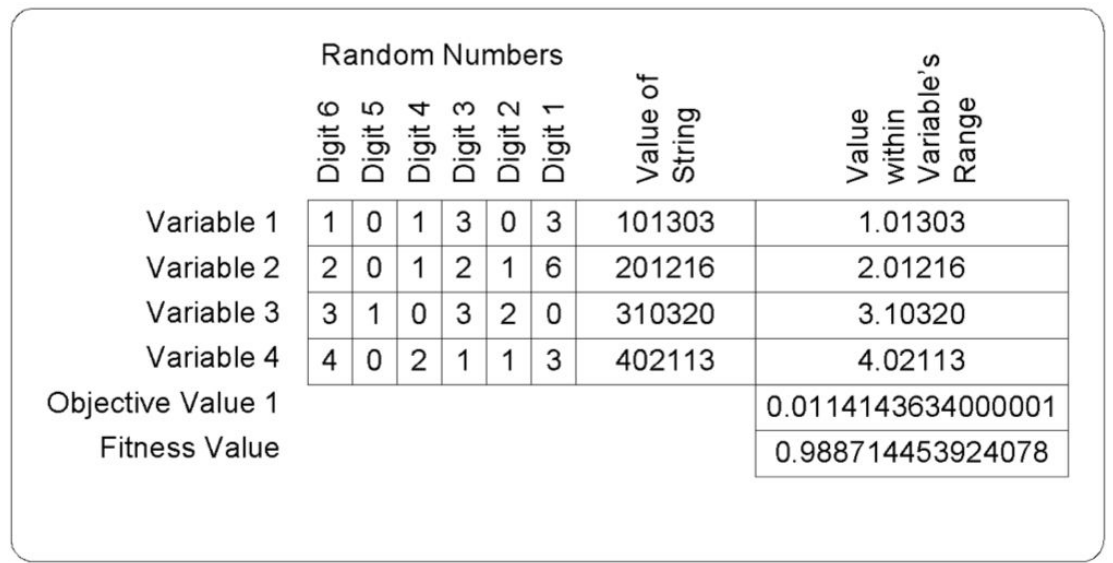
Figure 1: Structure of one Population